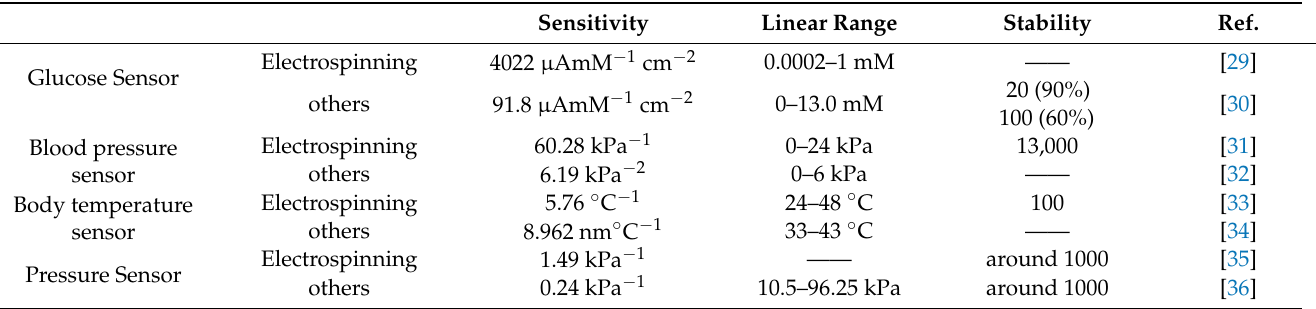
Table 1. Performance comparison with other sensors. Sensitivity Linear Range Stability